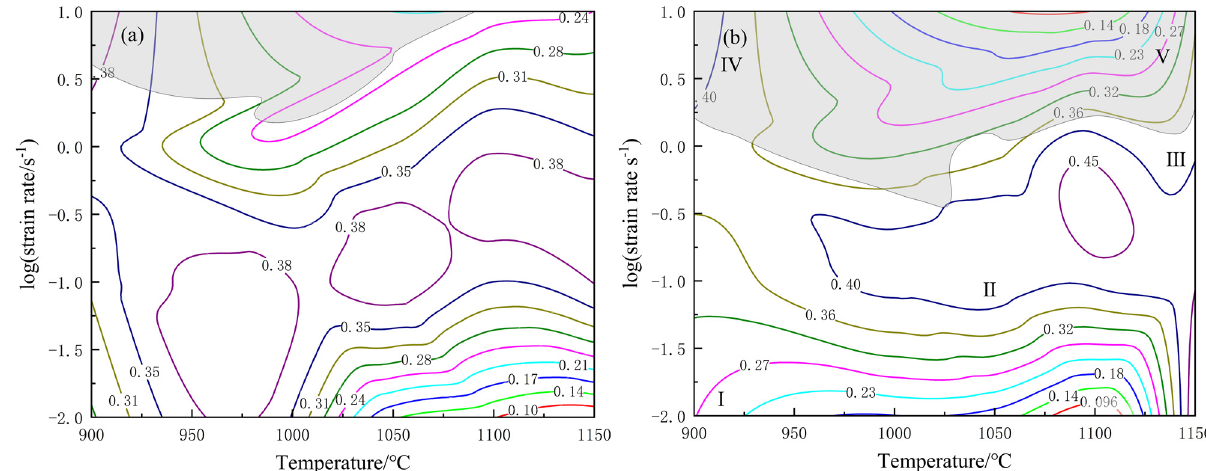
Figure 6: Processing maps of the studied 9Cr3W3Co - ODS steels at di ff erent strain: ( a ) 0.4; ( b ) 0.6. The gray - shaded area indicates unstable region. I – V represent fi ve di ff erent deformation regions. Contour lines denote power dissipation e ffi